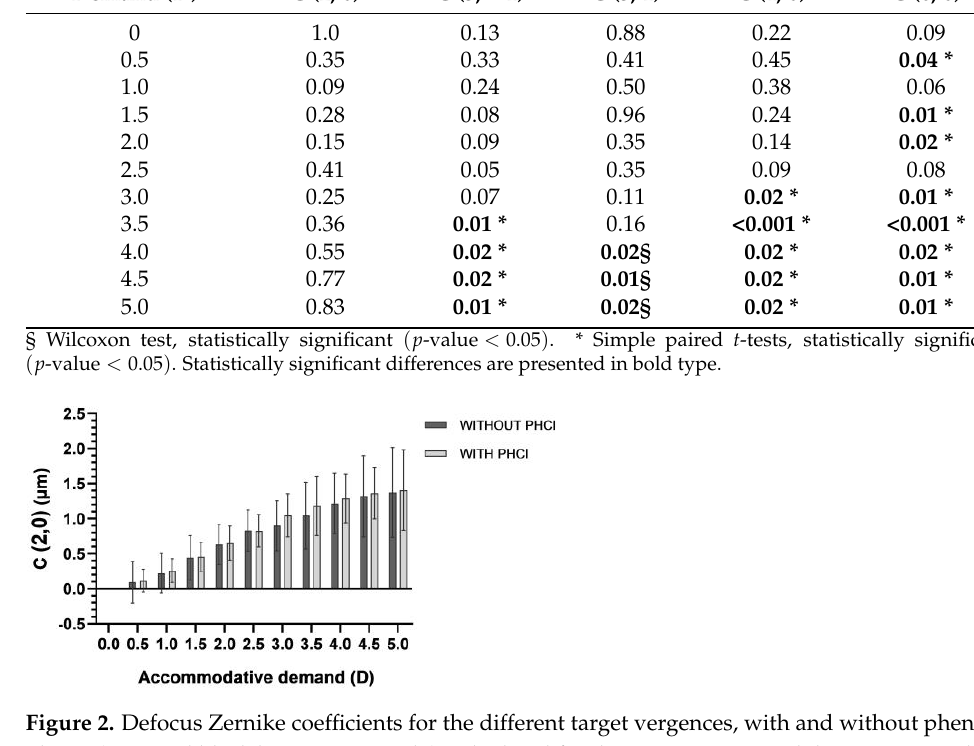
, C − 1 , C 1 , C 0 and 3 2 3 4